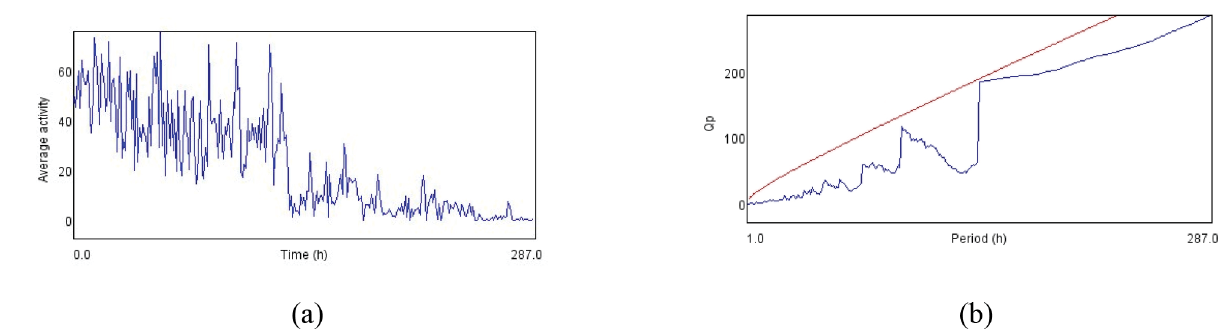
FIGURE 4S - (a) and (b) shows the average activity pattern and chi-square periodogram respectively for PD flies (N=20).